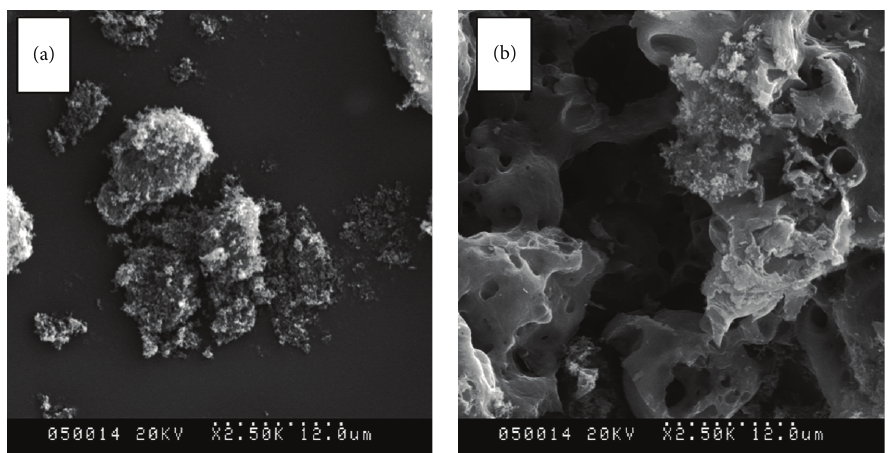
Figure 3: (a) SEM image of CB. (b) SEM image of MCB.